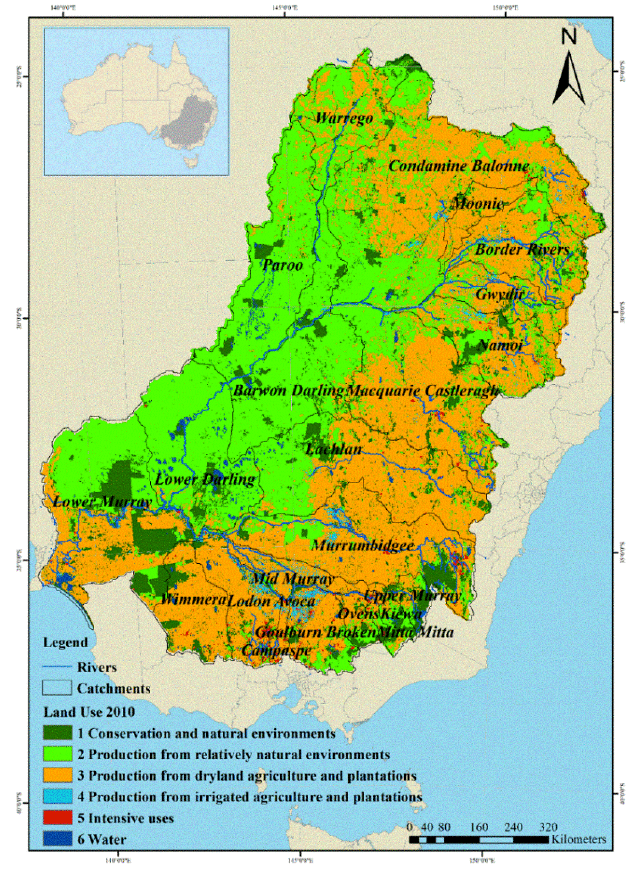
Figure 1. Location of the Murray Darling Basin (MDB). Land use data is extracted from “National scale land use version 5 (2010-2011)” through http://www.agriculture.gov.au.